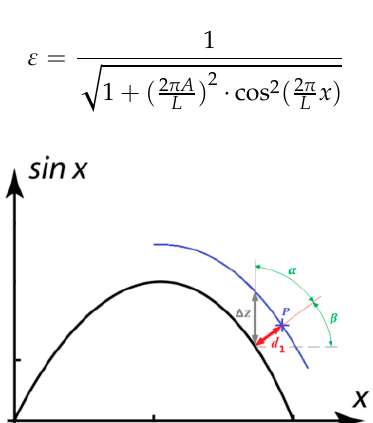
Figure 2. Geometrical relation between abscissa and minimum distance.